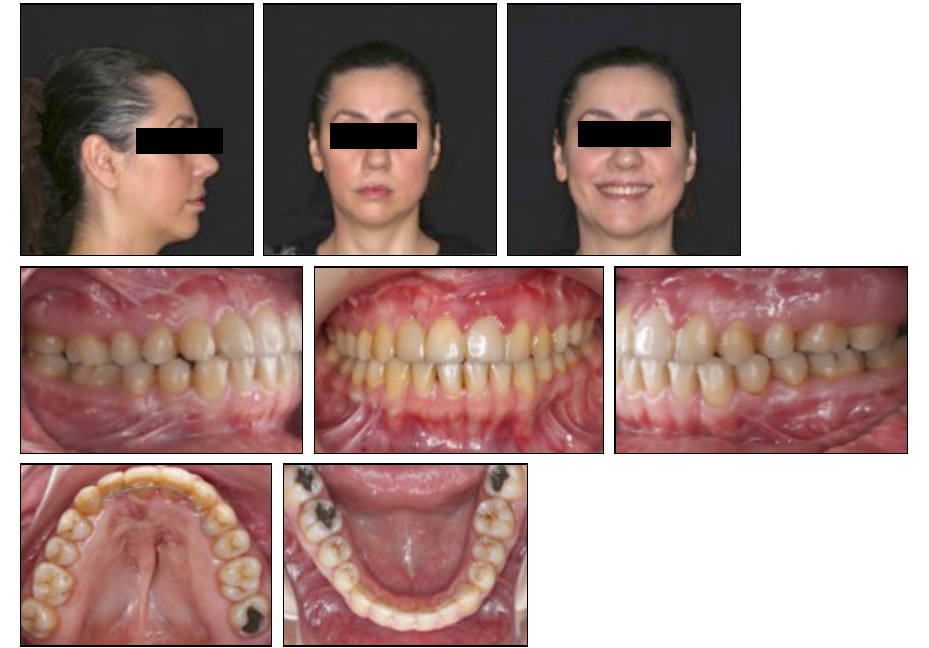
Figure 9. One-year post-treatment facial and intraoral